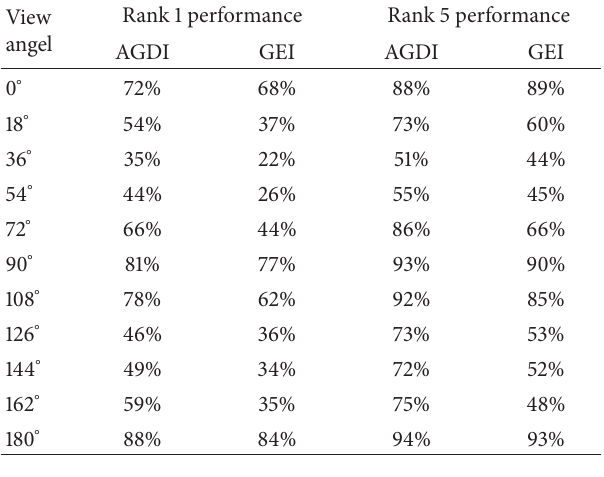
Table 1: Comparison of identification performance of AGDI and